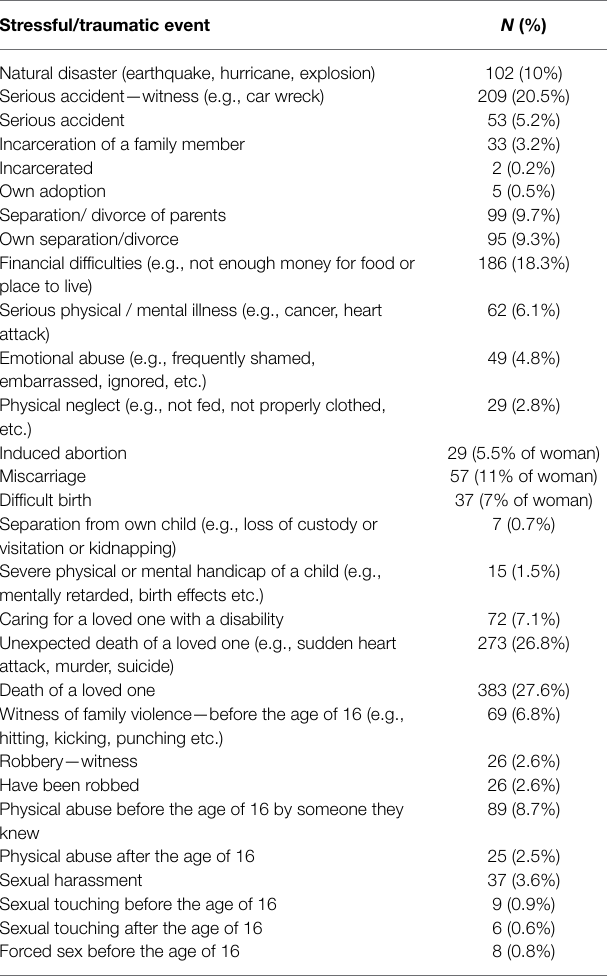
the meaning and purpose of life, four items on inner peace, and four items on faith. The reliability of the whole scale is high with ω total = 0.88. Examples of items: (1) I feel peaceful,